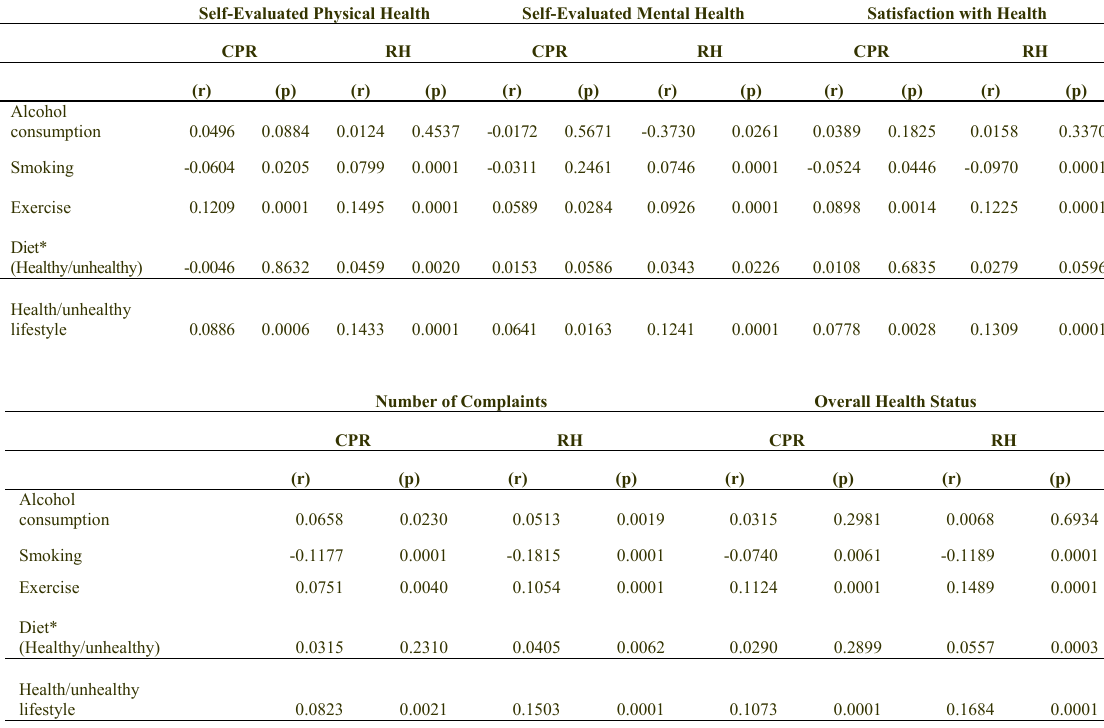
Pearson Correlation (r, p) between Lifestyle Factors and